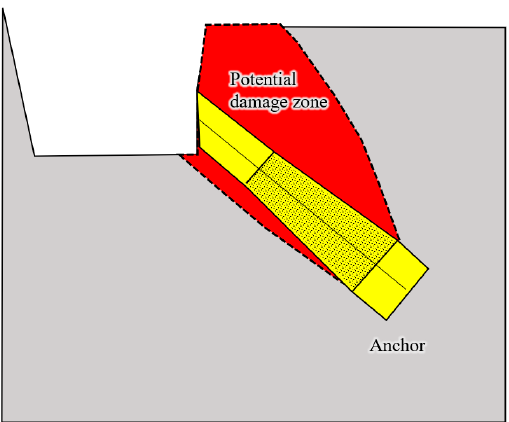
Figure 19. Diagram of potential failure model of tunnel anchor.